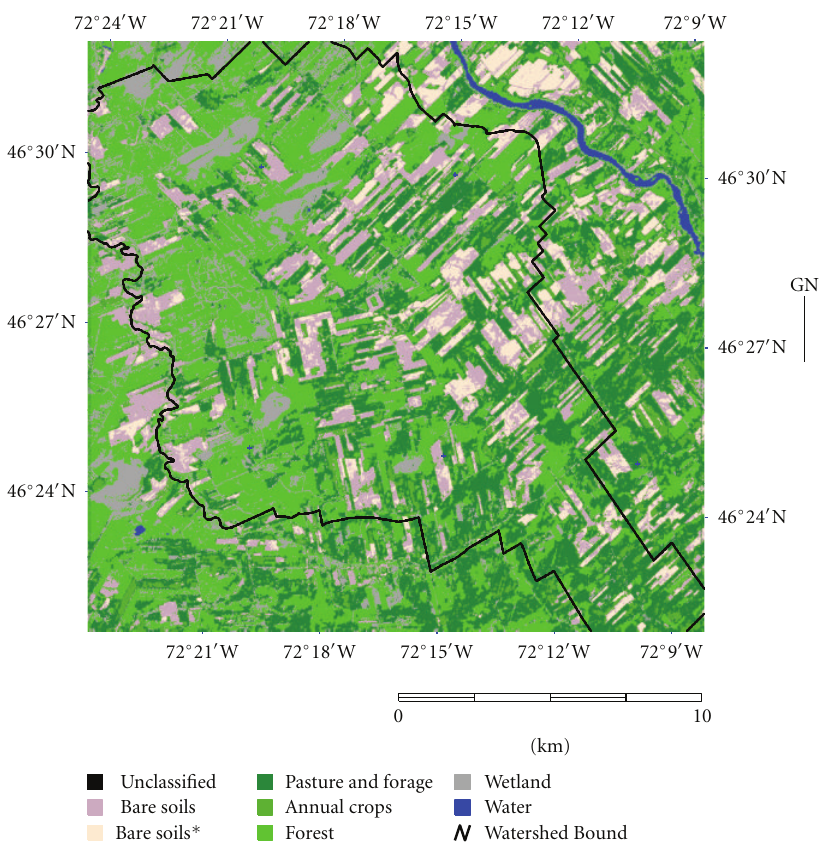
Figure 5: Map showing the spatial distribution of land use types (LUT) defined in the Bras d’Henri watershed using a supervised classification of the ASTER image